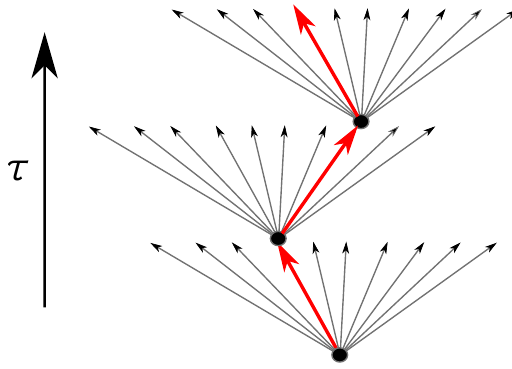
Figure 7 . A state can be evolved by the constraints with di(cid:11)erent choices of lapse and shift tensors. A speci(cid:12)c choice represents one of multi-(cid:12)ngered time evolutions. Here D s (cid:17) Q 1 ds ( l ) and s ( (cid:28) ) = s ( l ) with (cid:28) = l(cid:15) . D q , D t , D p , D v , D y , and q ( (cid:28) ), t ( (cid:28) ), c l =1 p ( (cid:28) ), v ( (cid:28) ), y ( (cid:28) ) are similarly de(cid:12)ned. Here (cid:28) is a parameter time that labels di(cid:11)erent c stages of evolution generated by the momentum and Hamiltonian constraints. Here q and p play the role of generalized coordinates and s and t are their conjugate momenta. 10 The c c sum over the shift and lapse tensors in eq. (4.14) represents di(cid:11)erent paths in which the state in the kinematic Hilbert space is projected to the gauge invariant state. A particular path of the shift and lapse tensor represents one of the multi-(cid:12)ngered time evolutions.